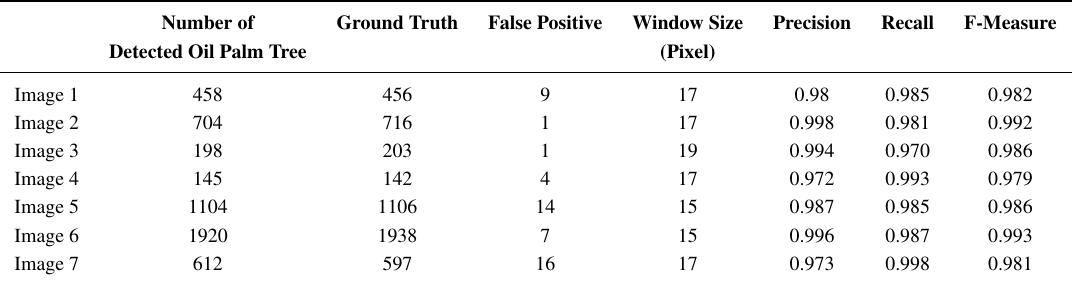
Table 3. Performance evaluation of the proposed method using Quickbird imagery. Number of Ground Truth False Positive Window Size Precision Recall F-Measure Detected Oil Palm Tree (Pixel)